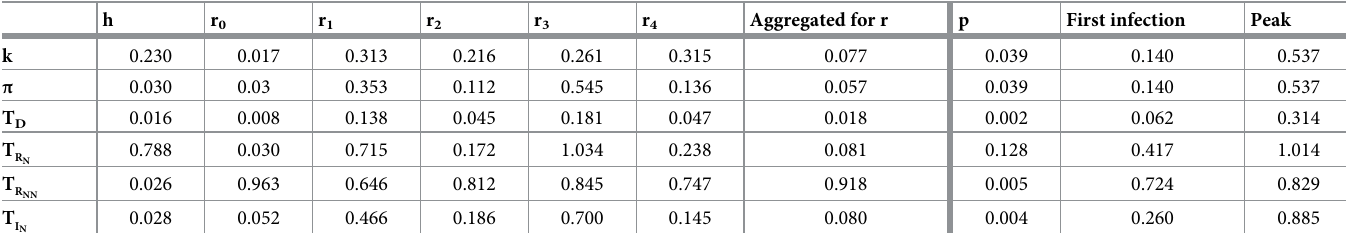
Values of the total index slightly exceeding 1 are due to MC approximation.approximation.